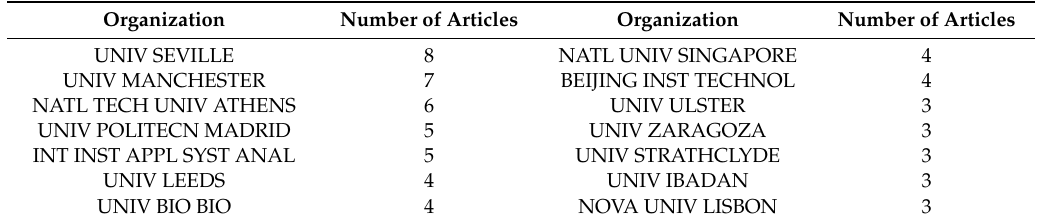
Table A4. Most prolific organizations.